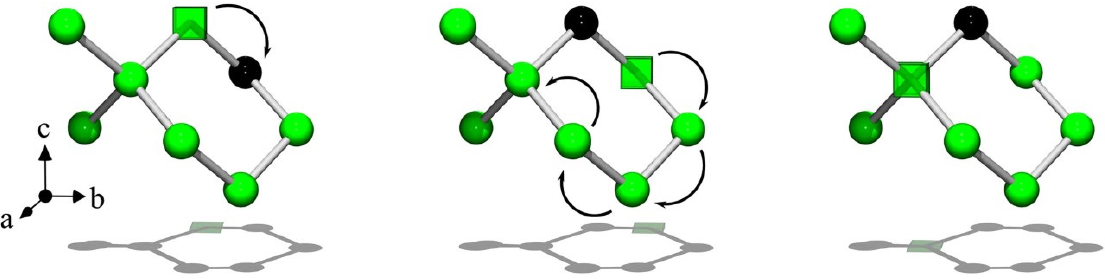
Figure 2. The ring mechanism of diffusion in a Ge lattice [59].